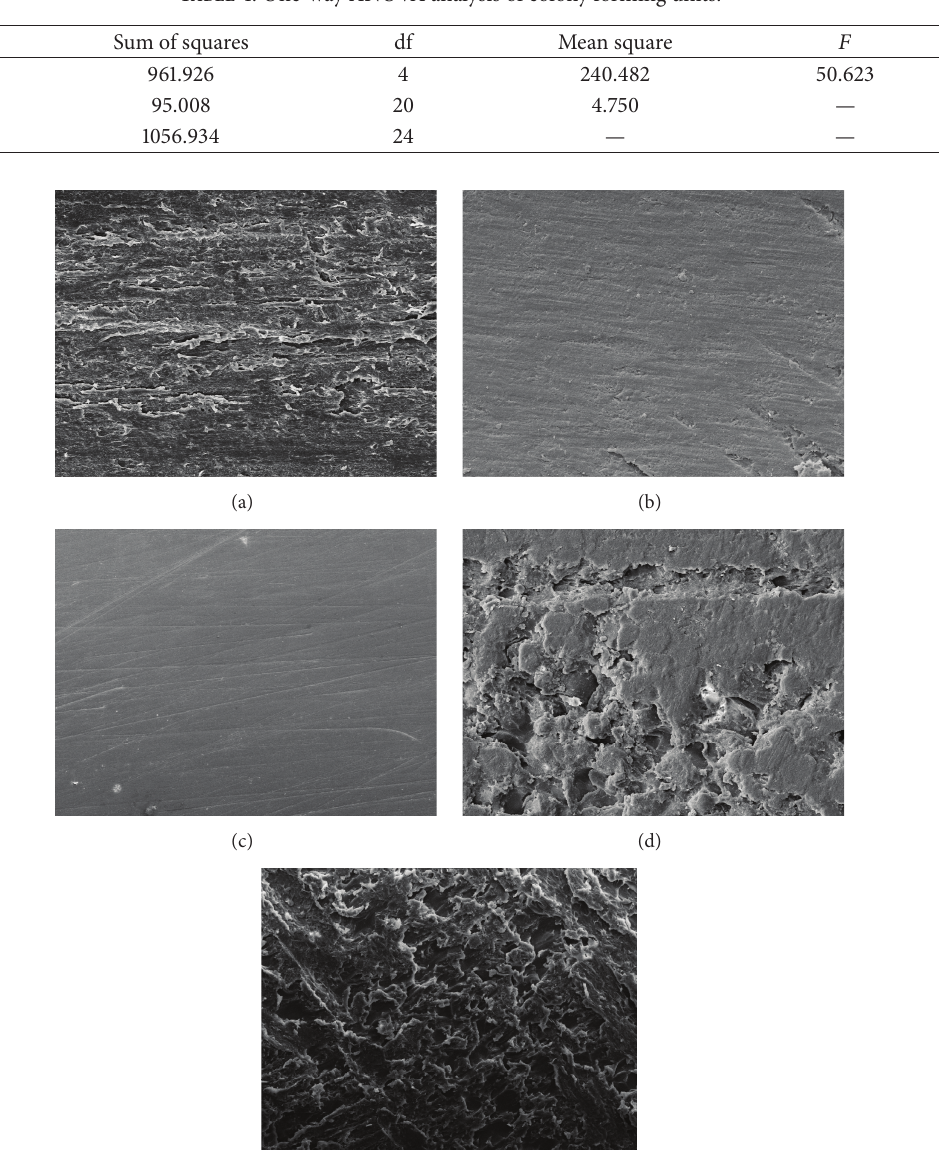
Figure 2: SEM images of sample topographies at 150x magnification. (a) MF; (b) MP; (c) LP; (d) NP; (e) NF.